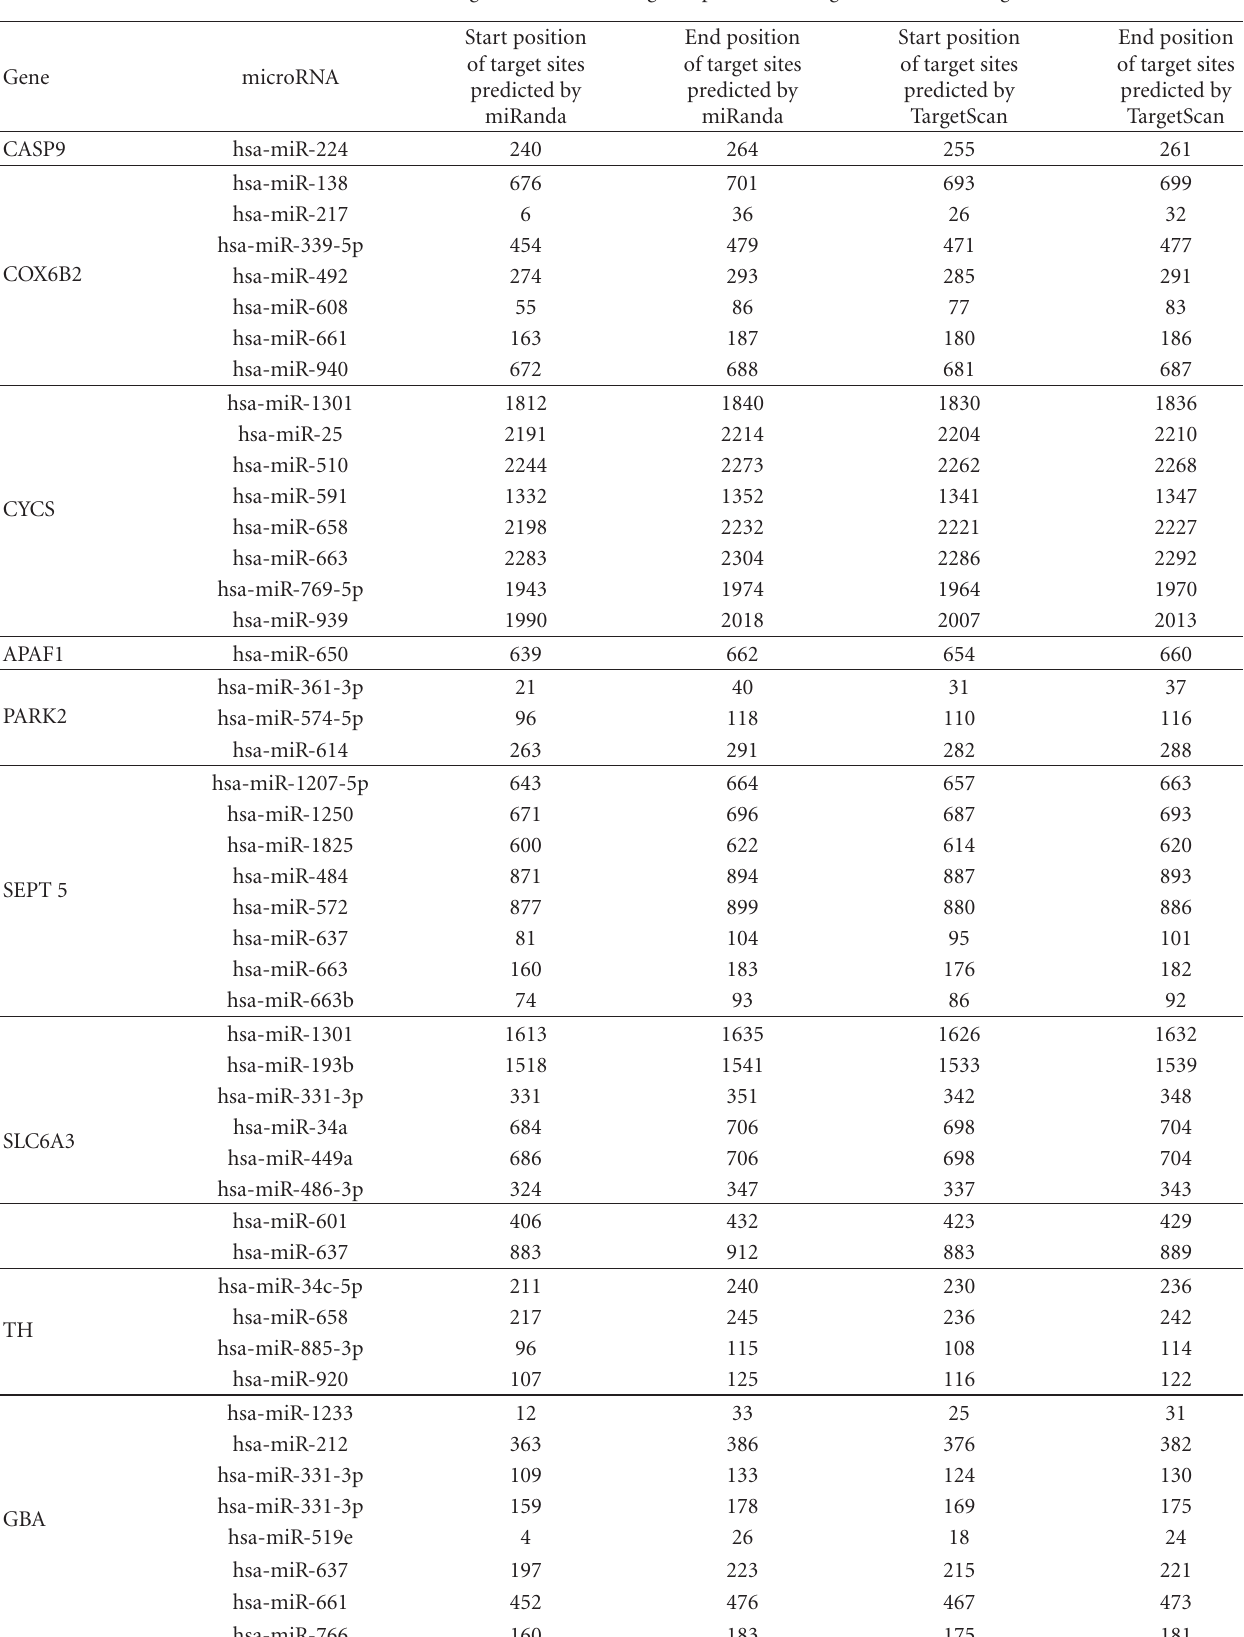
Table 2: Common microRNA target sites for various genes predicted using miRanda and TargetScan.